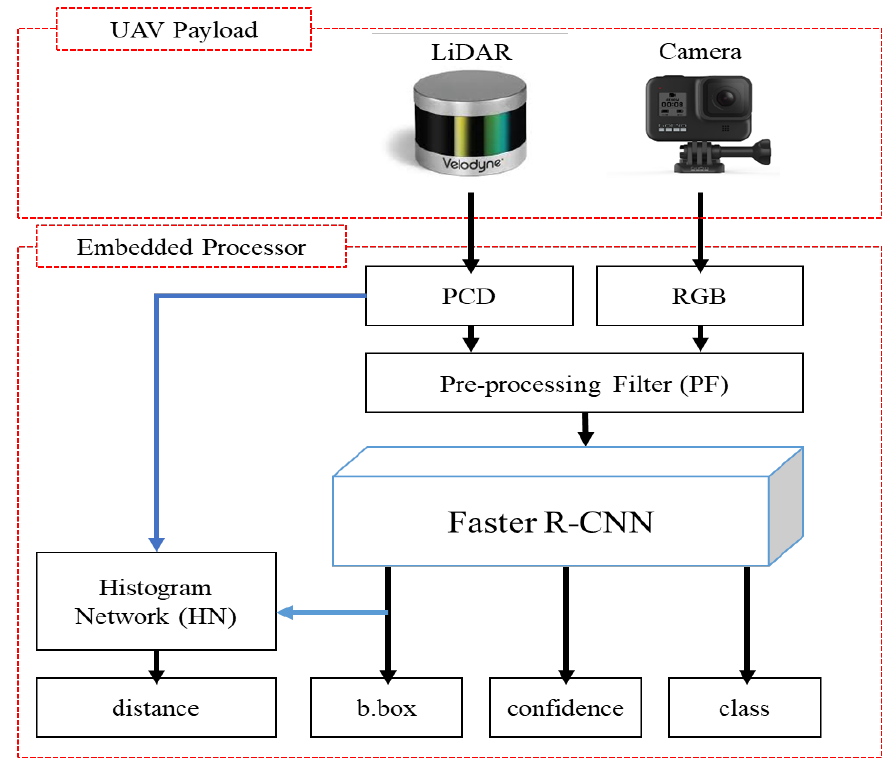
Figure 1. Architecture of proposed multimodal aerial data-based object detection system.